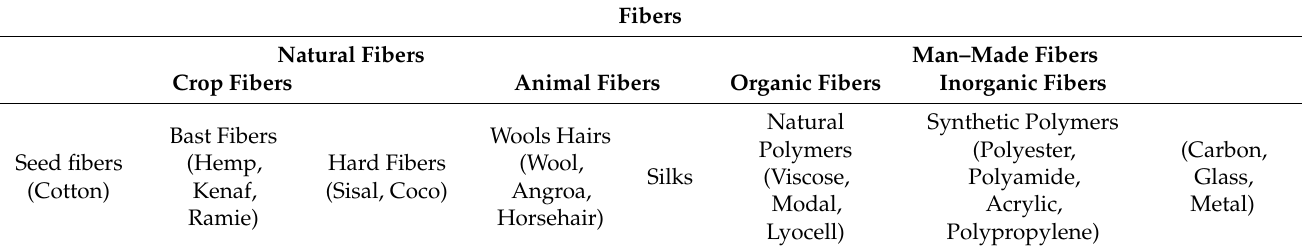
Table 1. Type of important fibers (modified from